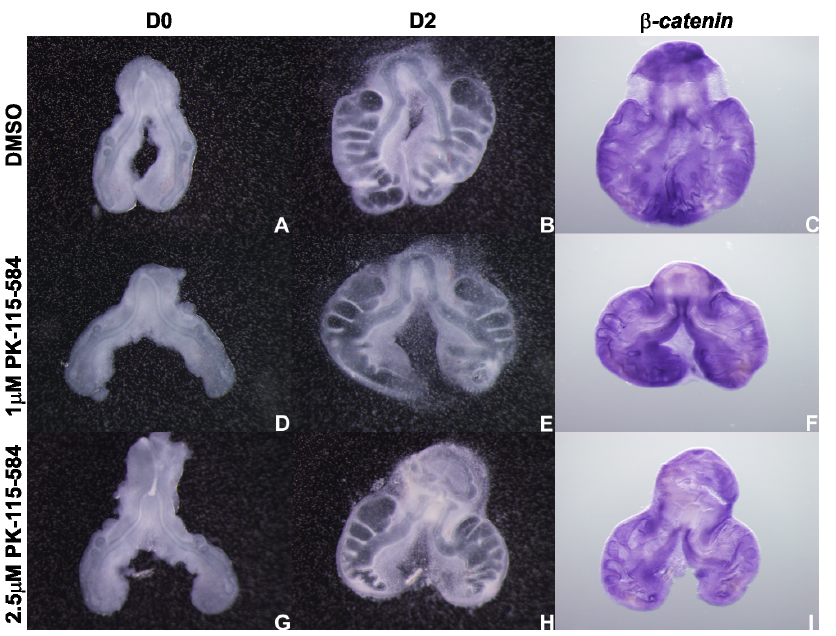
Figure 10. In vitro Wnt signaling inhibition (PK115-584) and b -catenin expression. Representative examples of stage b2 lung explant culture, at D0:0h (A, D, G) and D2:48h (B, E, H) treated with DMSO (A, B), 1 m M (D, E) and 2.5 m M (G, H) and probed with b -catenin (C, F, I); n 5 4 for each stage. Magnification: A, B, D, E, G, H –4x; C, F, I